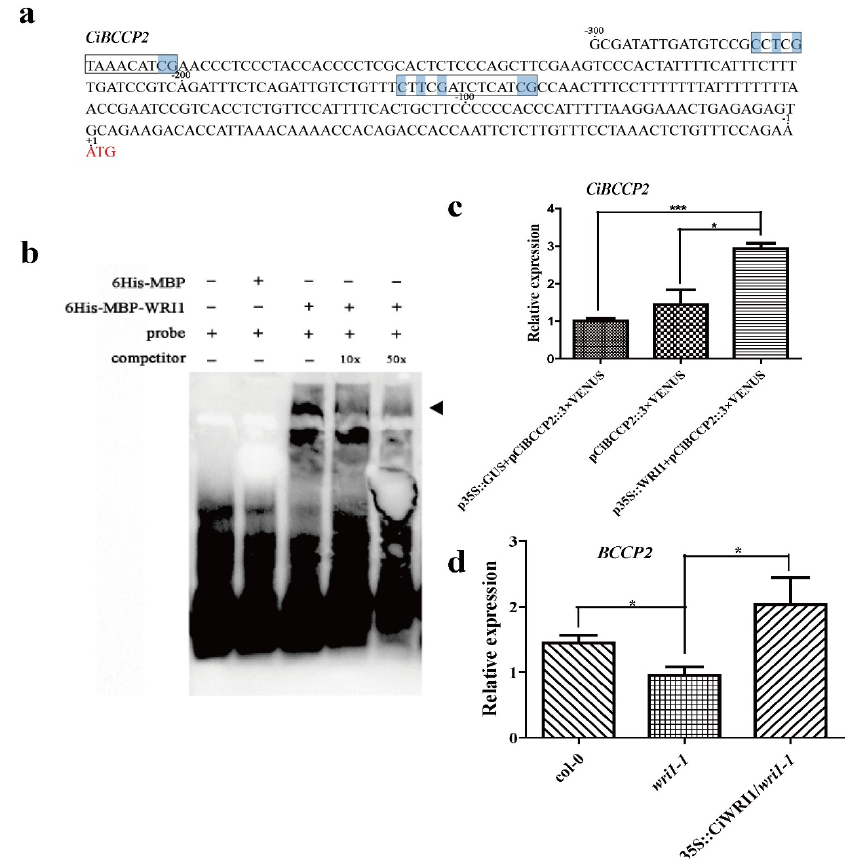
Figure 7. Positive regulation of CiBCCP2 by CiWRI1. ( a ) Two predicted ASML1/WRI1 (AW)-boxes (shown in boxes) in the CiBCCP2 promoter; the first (P1) is located in the region from 271 bp to 284 bp and the second (P2) from 165 bp to 178 bp upstream of ATG (red). ( b ) EMSA showing the binding of CiWRI1 to the CiBCCP2 promoter. The fragment containing the first (P1) AX-box sequence was used as a probe. The arrow shows specific interactions. ( c ) Upregulation of CiBCCP2 by co-expression of p35 S: CiWRI1 vector in tobacco. Results are representative of three independent biological replicates. ( d ) BCCP2 expression in wild-type Col-0, wri1-1 mutant, and p35 S: CiWRI1/wri1-1 transgenic Arabidopsis . Three individual p35 S: CiWRI1/wri1-1 transgenic plants were used for qRT-PCR. * p < 0.05, *** p < 0.001 (Student’s t test).